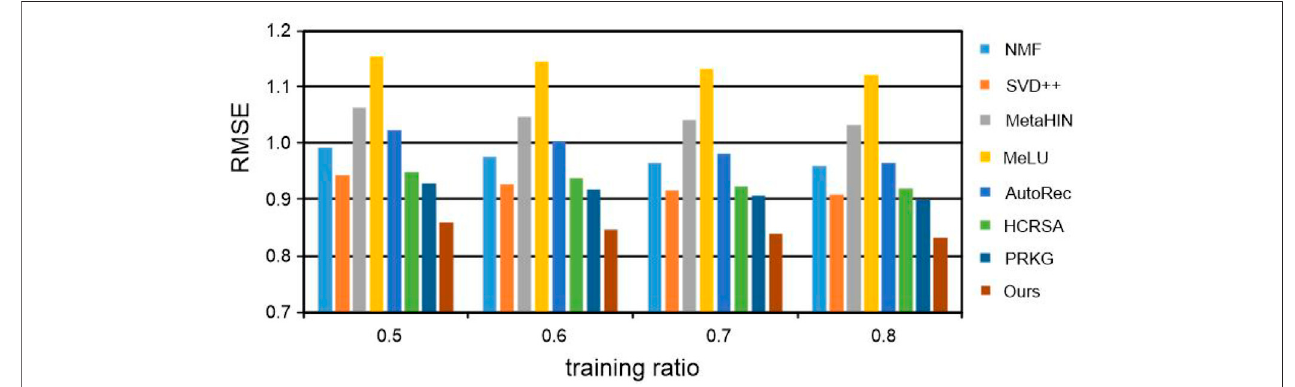
FIGURE 3 | RMSE of our KGTA and compared methods on the MovieLens 100K dataset.